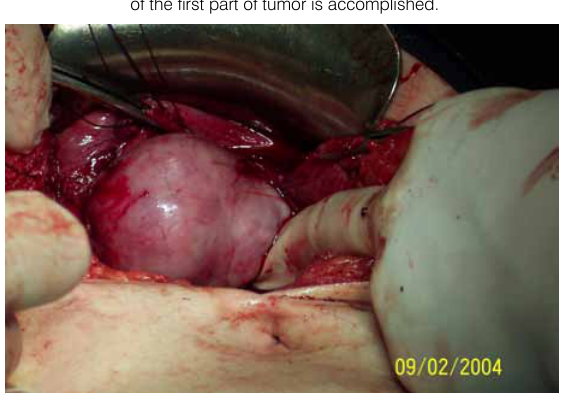
Figure 2. After hysterectomy, division of sacrouterine ligaments was done, retroperitoneal space is entered, and excision of the first part of tumor is accomplished.